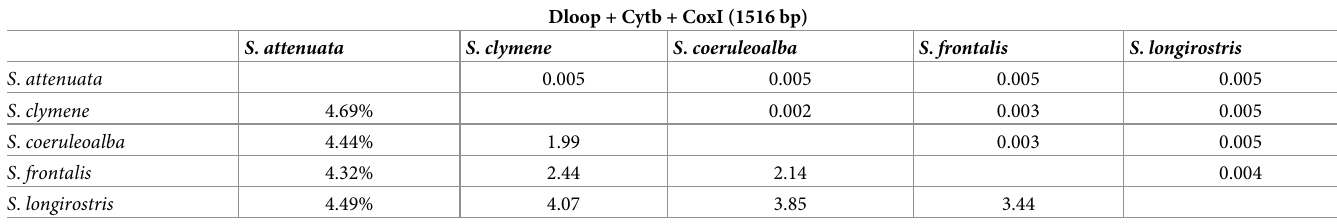
Table 2. Genetic distances between Stenella species from Brazilian waters for 1516 bp of mtDNA (Dloop + Cytb + CoxI). Genetic distance values (%) are bellow diag- onal, and, standard errors (SEs) are upper diagonal. Dloop + Cytb + CoxI (1516